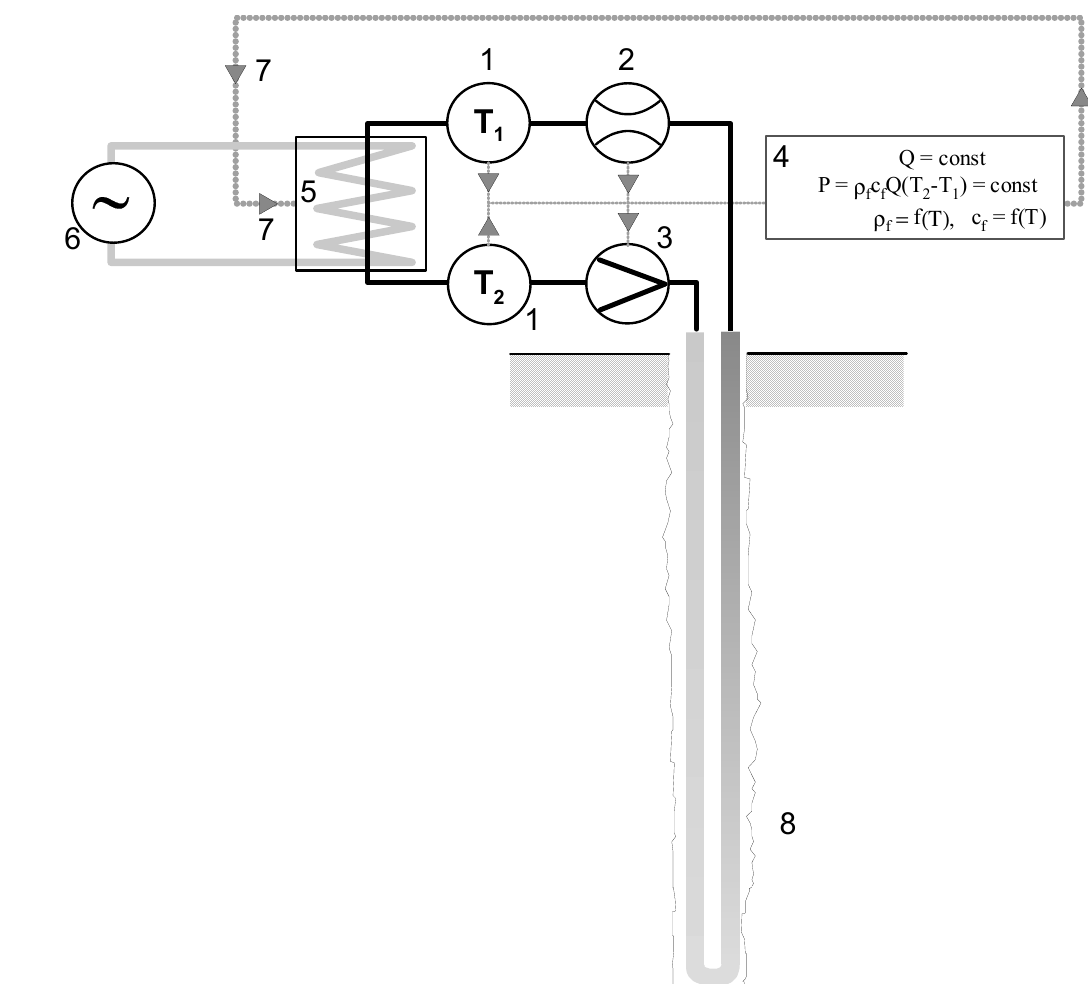
Figure 2. Schematic of thermal response test devices and operation. Legend: 1–thermometer, with absolute error 0.1 ◦ C, 2–flowmeter, 3–pump, 4–control computer (stabilisation of thermal power and record the data), 5–set of heaters, 6–current source, 7–heater control signal, 8–borehole heat exchanger, Q –flow rate of heat carrier, P –heat flow rate (power), T 1 –temperature of heat carrier (outflow from borehole heat exchangers (BHE)), T 1 –temperature of heat carrier (inflow to BHE), ρ f = f( T )–density of heat carrier as a function of temperature, and c f = f( T )–specific heat of heat carrier as a function of temperature.